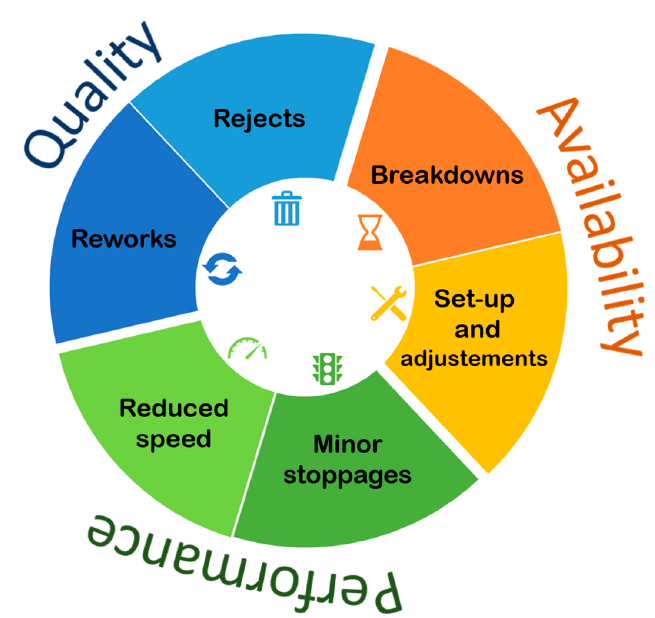
Figure 1. Six big losses.